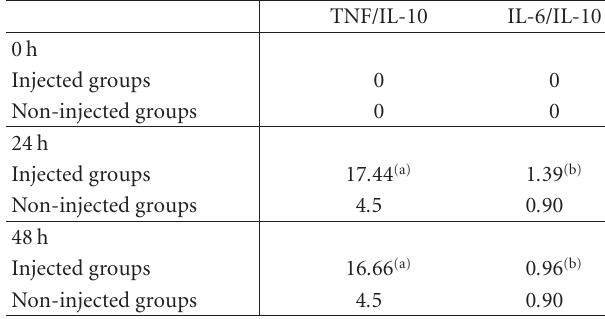
Table 1: Balance of pro- and anti-inflammatory cytokines. Groups of mice were injected subcutaneously with 1 LD 50 of CSV, nonin- jected group was treated with saline solution. Sera cytokine concen- trations (pg/mL) in injected groups and/or noninjected group at 24 and 48h of envenoming